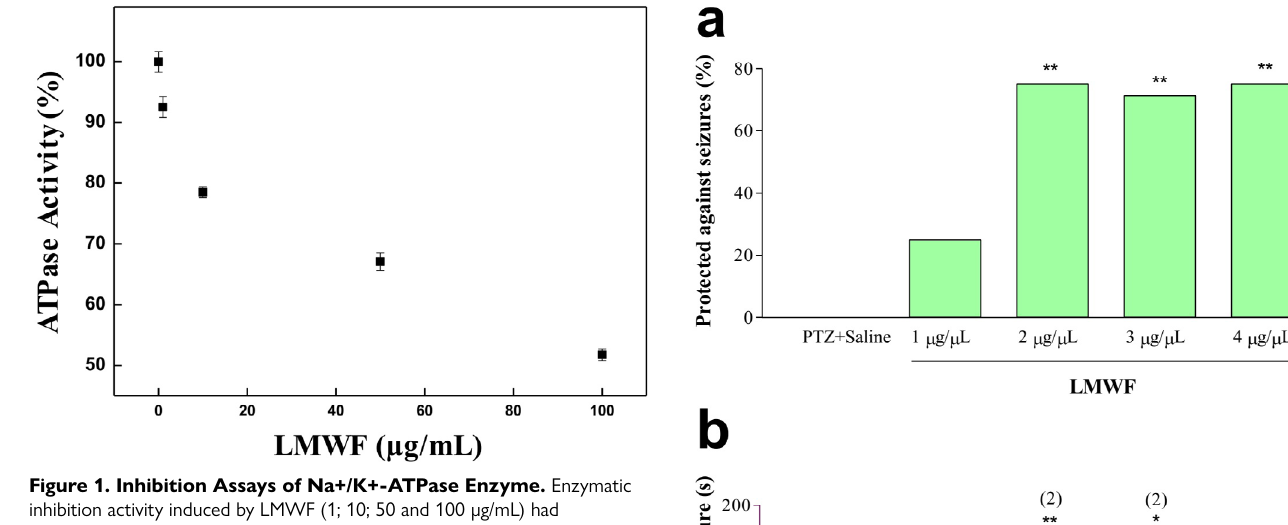
was 107.5 µg/ 50